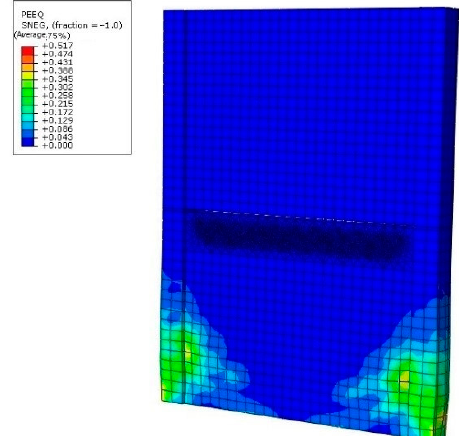
Figure 14. PEEQ of steel members for SPRC-2 (2).